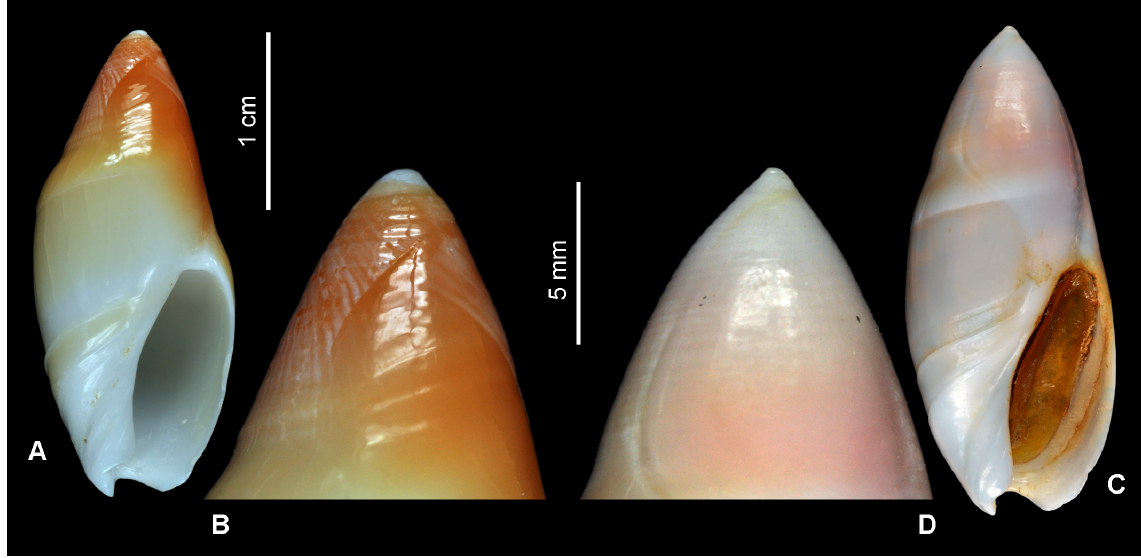
Fig. 17. Comparison of Amalda allaryi Bozzetti, 2007 with A. montrouzieri (Souverbie, 1860) . A–B . A. allaryi , MNHN IM-2013-68272, SL 26.2 mm, specimen not sequenced. C–D . A. montrouzieri , LAGON, stn DW51, Nouméa Sector, 22°15′ S, 166°11′ E, 10 m, SL 27.6 mm, specimen